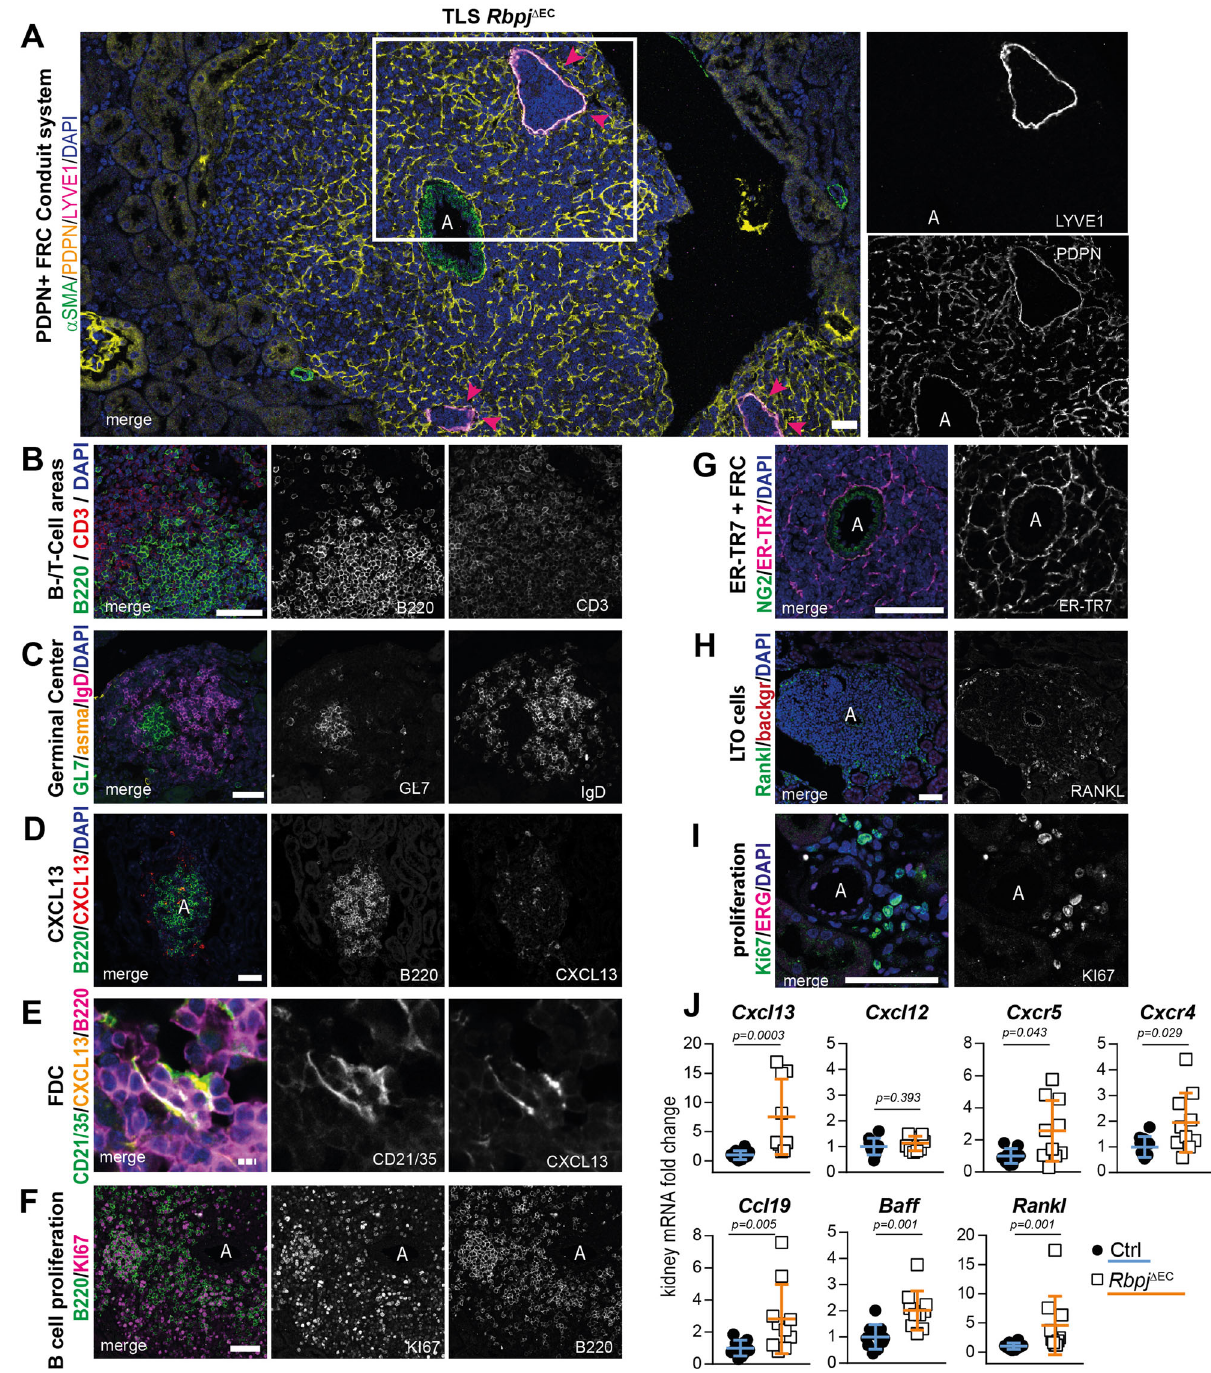
Fig. 2 Molecular, cellular and structural composition of periarterial TLS. A – I Immuno fl uorescence staining and confocal laser scanning microscopy of representative Rbpj Δ EC kidney samples, merged and single channels as indicated. “ A ” indicates artery. Optical Magni fi cation 200x; different scan areas (see scale bars). Scale: solid bar 50 µ m, dotted bar 10 µ m (2E). Each micrograph is representative of at least 4 biological replicates. J Whole kidney mRNA expression, relative fold change to control gene Rps9 , n = 10/group. Graphs: Scatter dot blot, mean, SD (whiskers). Mann – Whitney test, two-tailed, Exact p -values: Cxcl13 , p = 0.0003; Cxcl12 , p = 0.393; Cxcr5 , p = 0.0433; Cxcr4 , p = 0.0288; Ccl19 , p = 0.0052; Baff , p = 0.0007; Rankl , p = 0.0005. Source data are provided as a Source Data fi